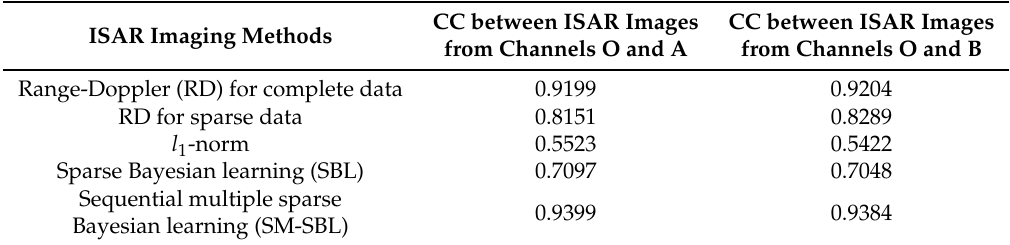
Table 1. Correlation coefficients (CC) of multi-channel inverse synthetic aperture radar (ISAR) images for random missing sampling (RMS).